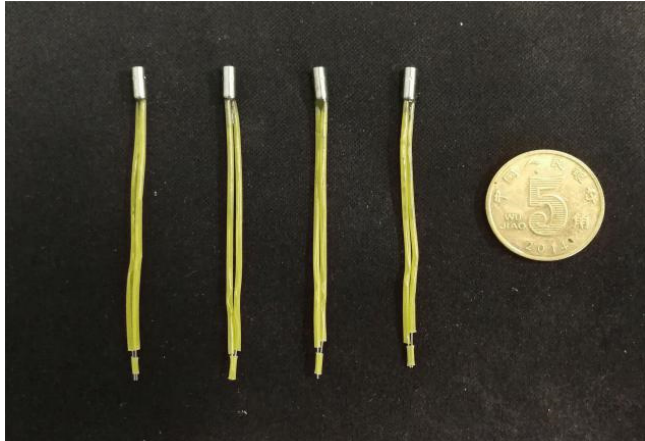
Figure 21. Pin pusher. Table 4. Main parameters of pin